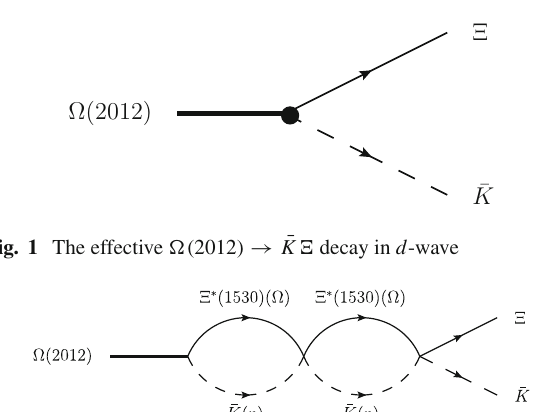
Fig. 2 The (cid:2)( 2012 ) → ¯ K (cid:3) decay through the re-scattering of the ¯ K (cid:3) ∗ ( 1530 ) and η(cid:2) channels